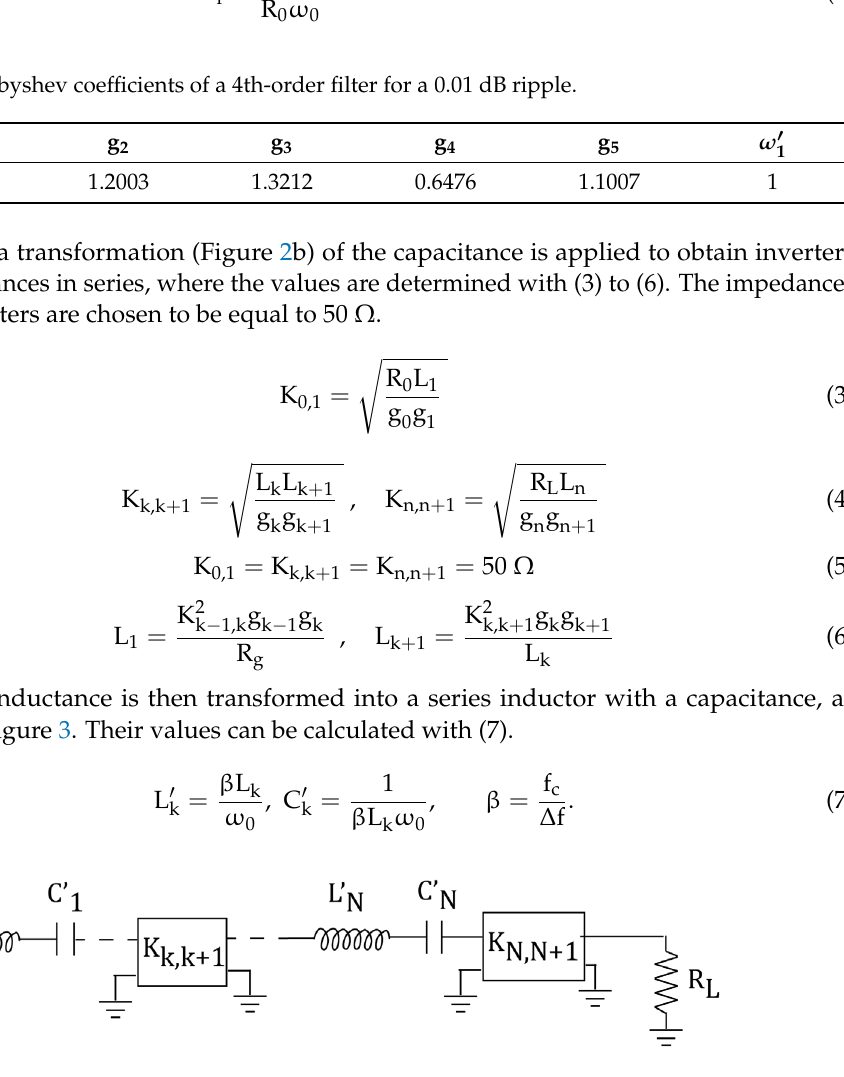
Figure 3. Bandpass filter prototype.